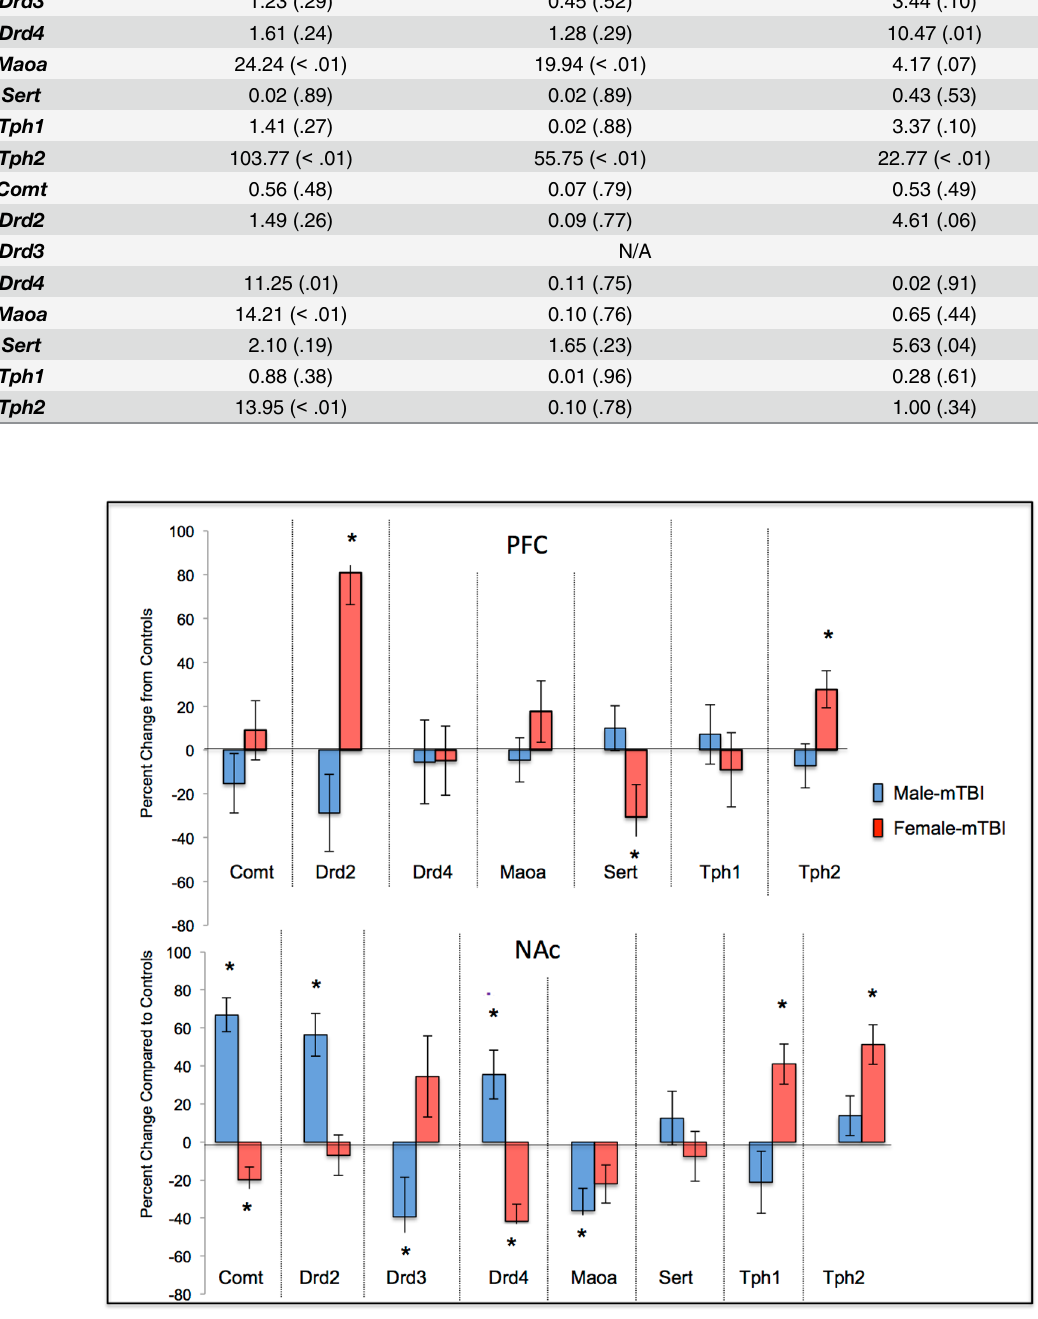
Fig 4. Changes in gene expression for STD male and female animals with a mTBI. The centerline represents typical expression (STD-shams) with the bars exhibiting percent changes from normal ( * main effect of mTBI p <